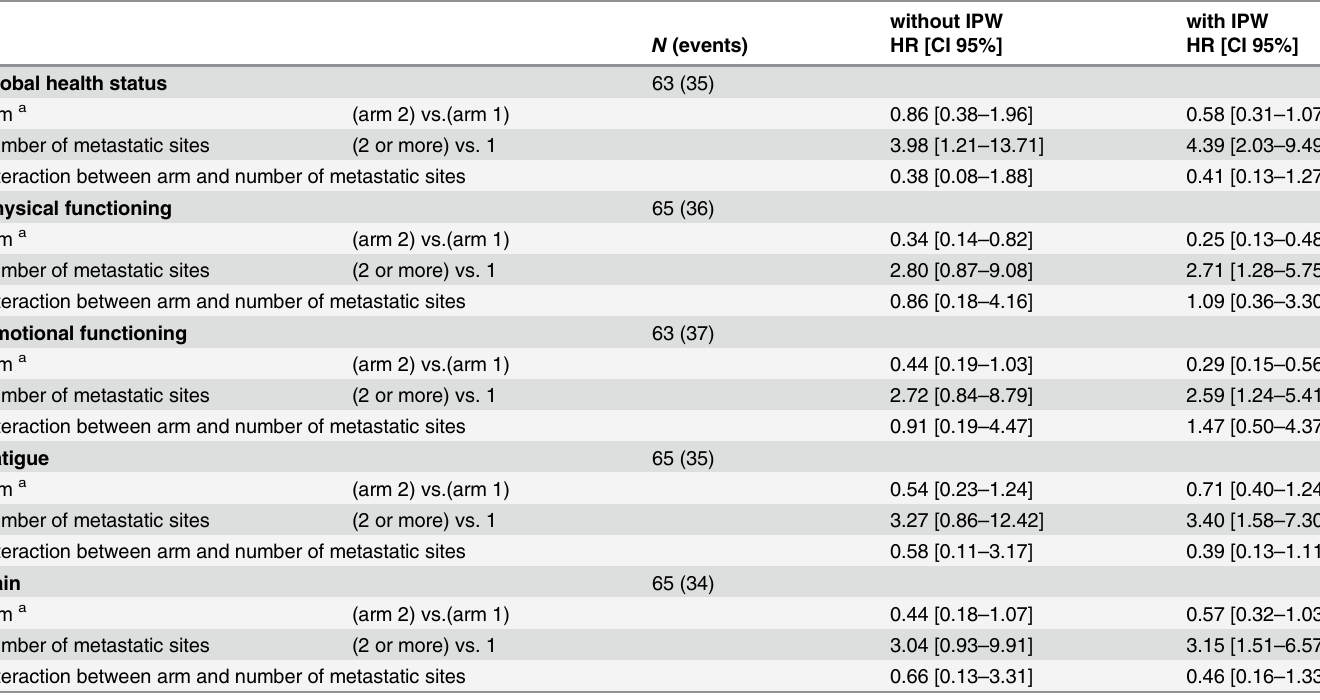
Table 5. Results of the multivariate Cox regression analysis for the QFS analysis of each targeted score of the QLQ-C30 for the raw and the weighed